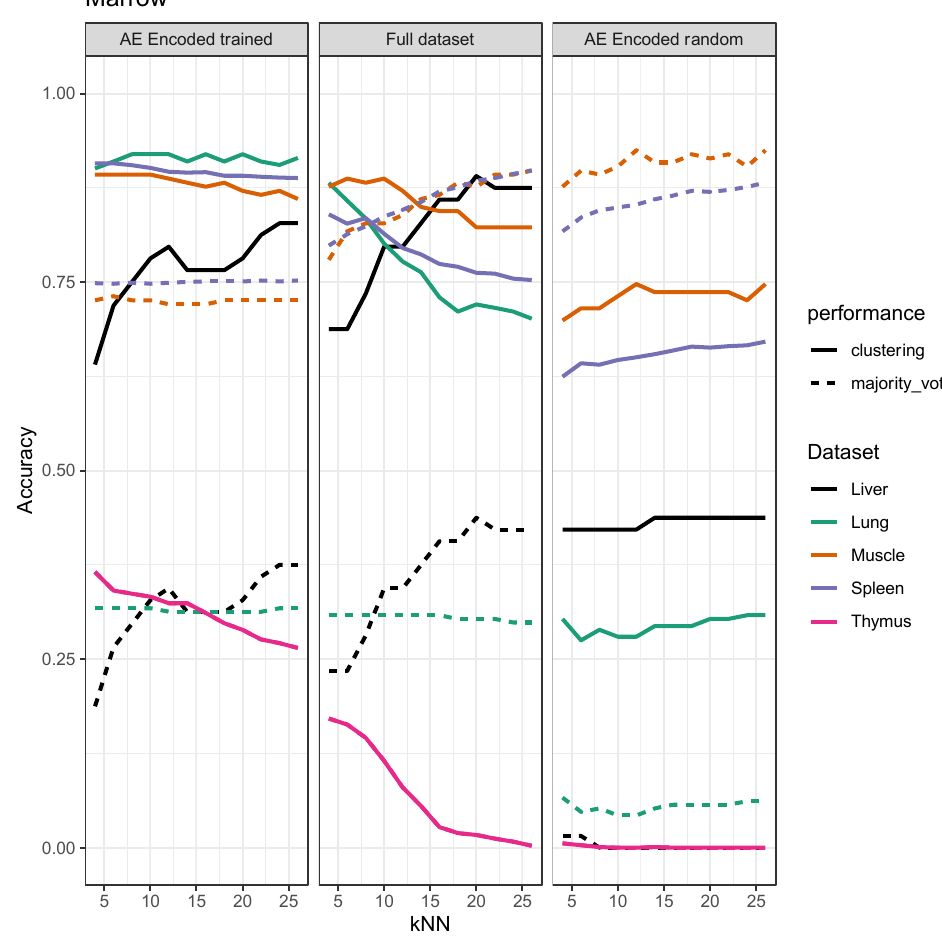
Figure 3. Example kNN-model predicting accuracy of common cell type labels. The kNN was trained on Marrow dataset from Smart-seq2, on the datasets encoded by a trained autoencoder, full dataset, and a randomly initialized autoencoder. Predicting cell type labels for the other Smart-seq2 datasets. Dashed line indicates performance when taking a majority vote as prediction, which assigns all cells to the most abundant cell type. The left represents the kNN model trained and tested on the encoded datasets, the middle represents the kNN model trained and tested on the full dataset and the right represents the kNN trained and tested on data encoded by a randomly initialized autoencoder.